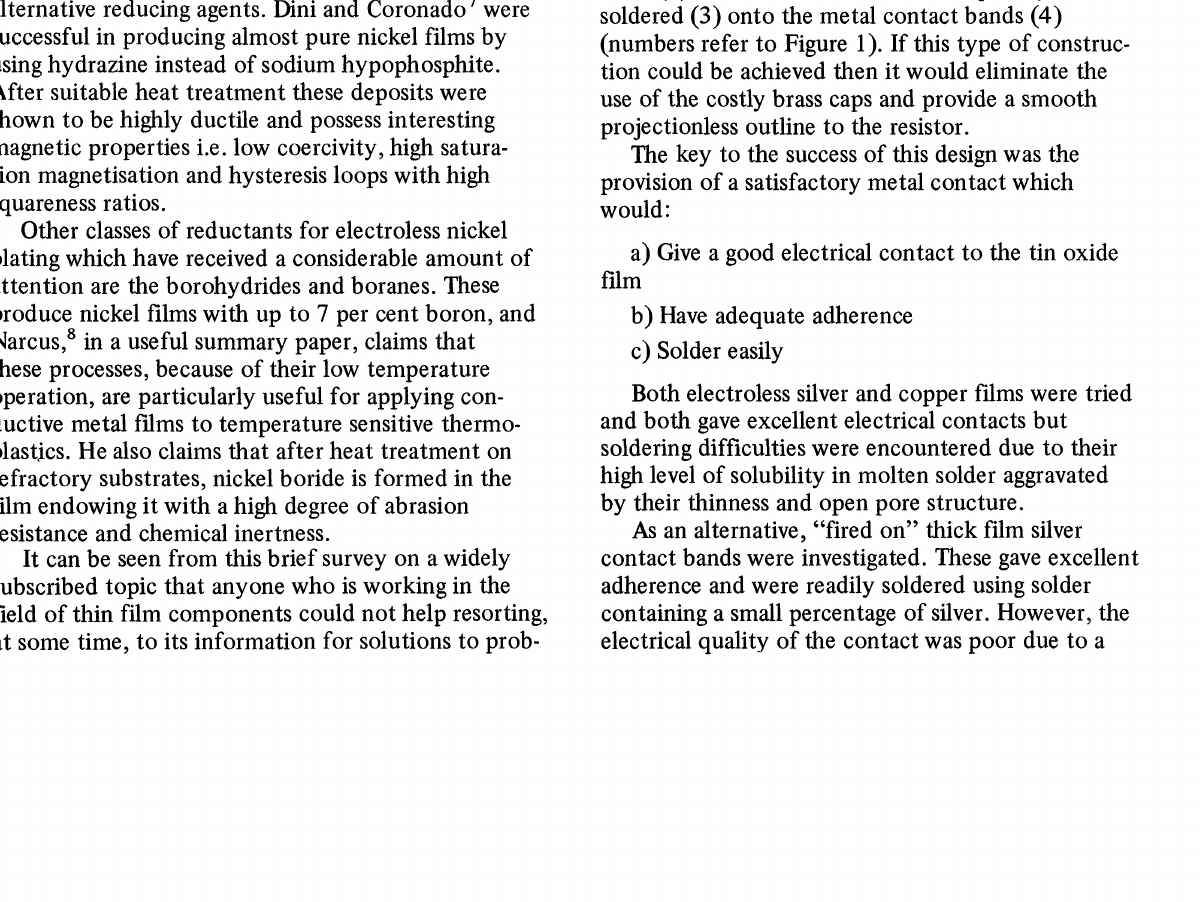
Capless Resistor